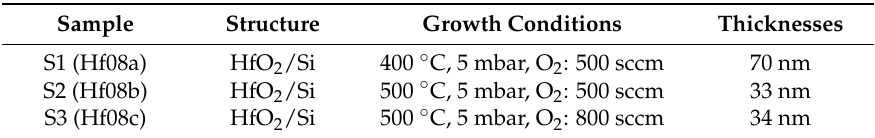
Table 1. Growth conditions and measured thicknesses of HfO 2 thin films by TEM, from the grower.